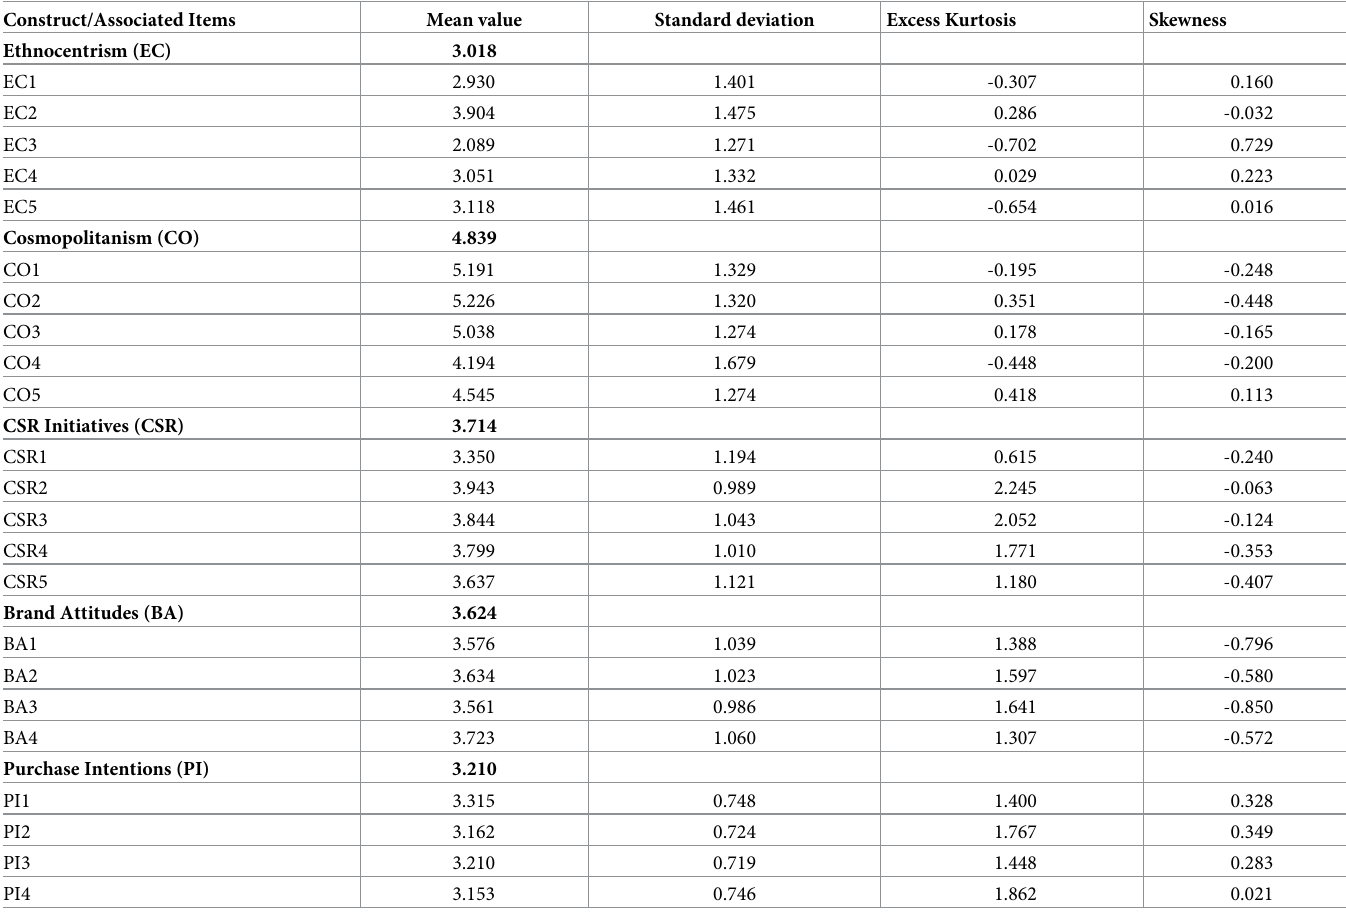
Table 2. Descriptive